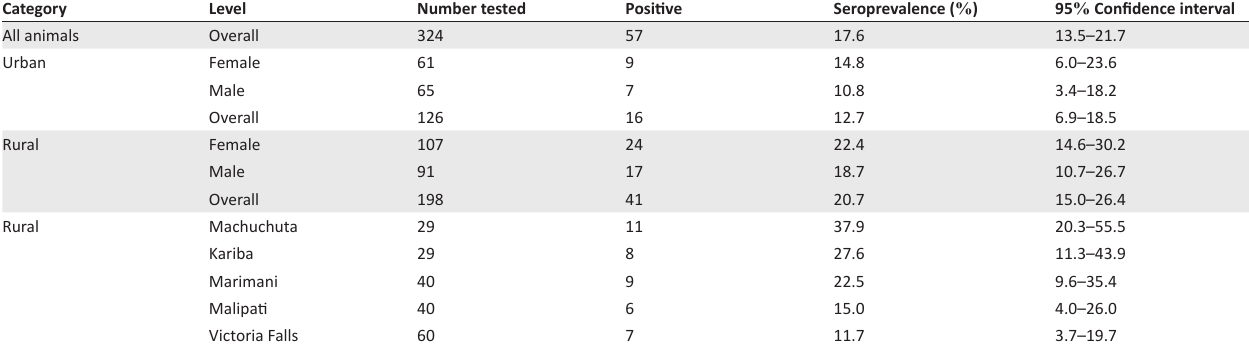
TABLE 1: Distribution of Brucella canis seroprevalence according to sex and location. Category